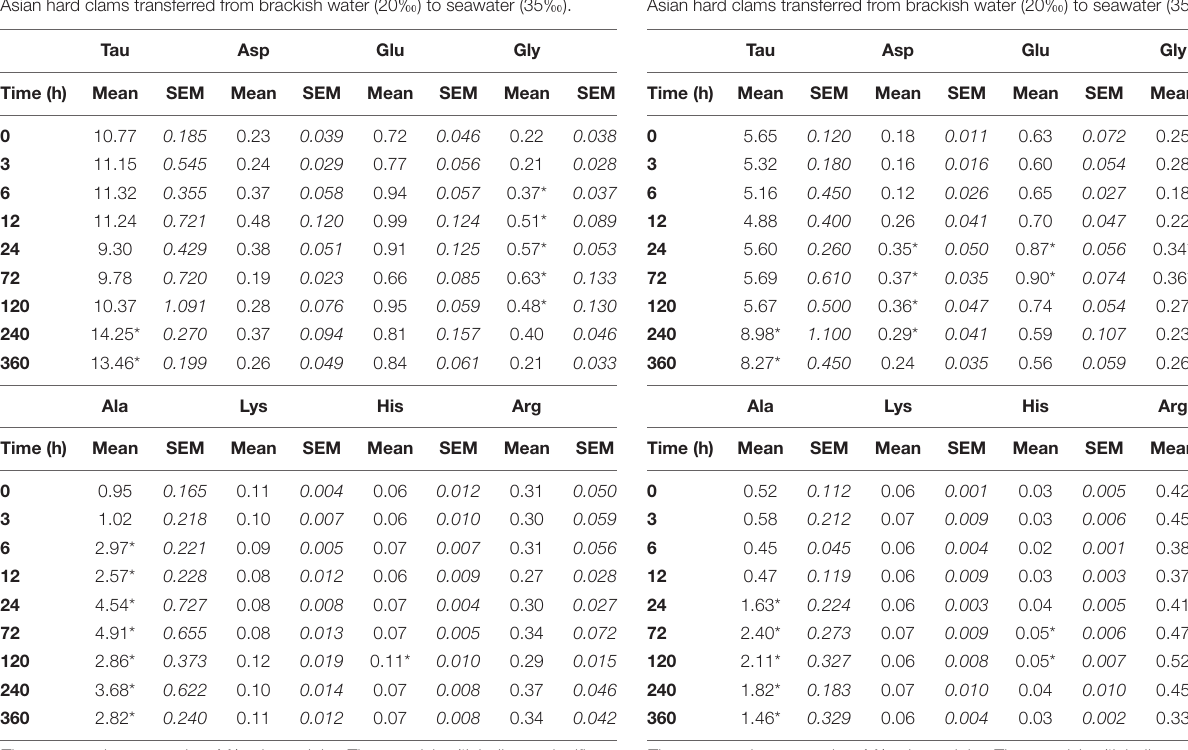
The mean values were in µ M/g dry weight. The asterisks (*) indicate significant differences between various time points and 0 h by Dunnett’s test following one- way analysis of variance (p < 0.05). N = 5. SEM values are shown in italics. Tau, taurine; Asp, aspartate; Glu, glutamate; Gly, glycine; Ala, alanine; Lys, lysine;